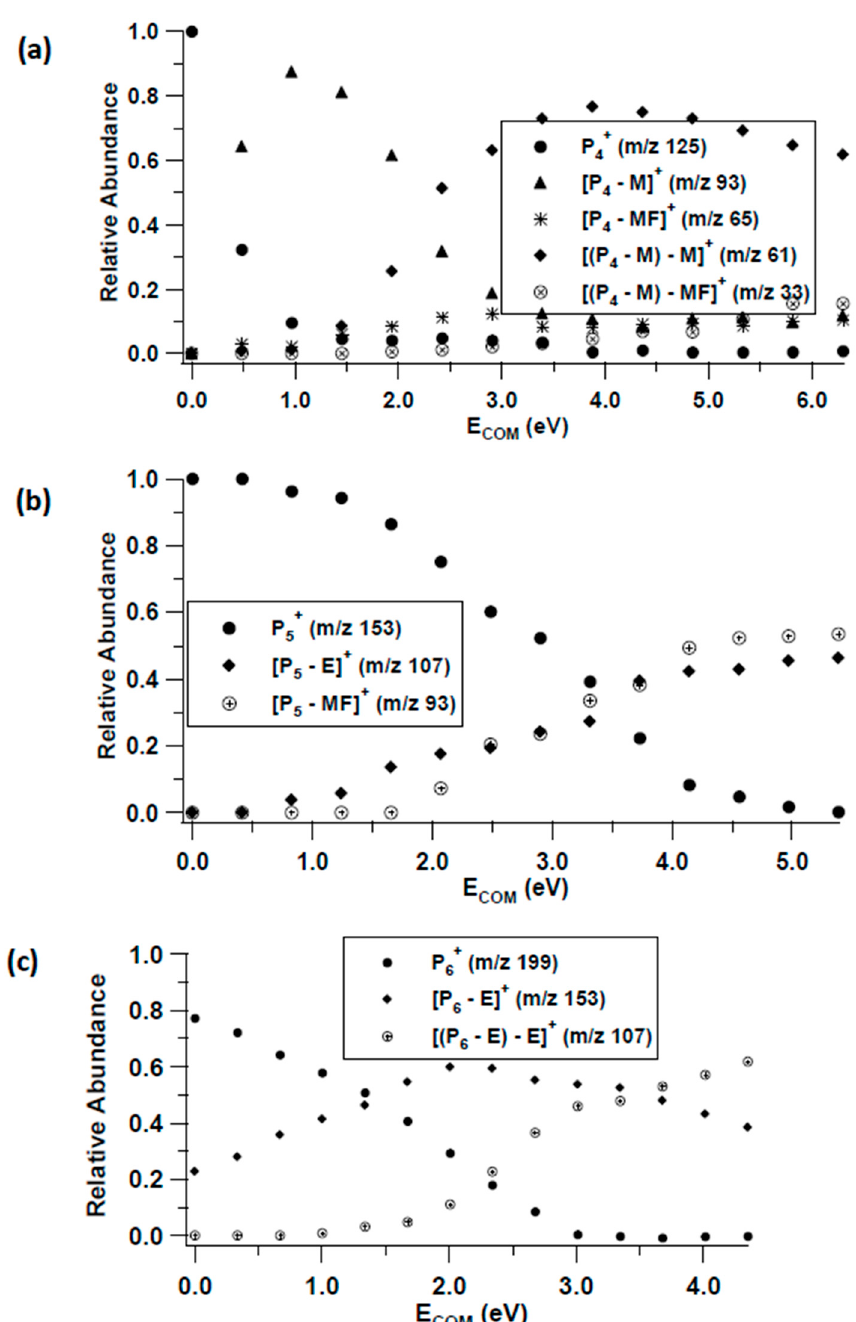
Figure 4. CID breakdown curves of ( a ) P 4+ = MF(M) 2 H + , ( b ) P 5+ = MF(E) 2 H + and ( c ) P 6+ = MF(E) 3 H + .